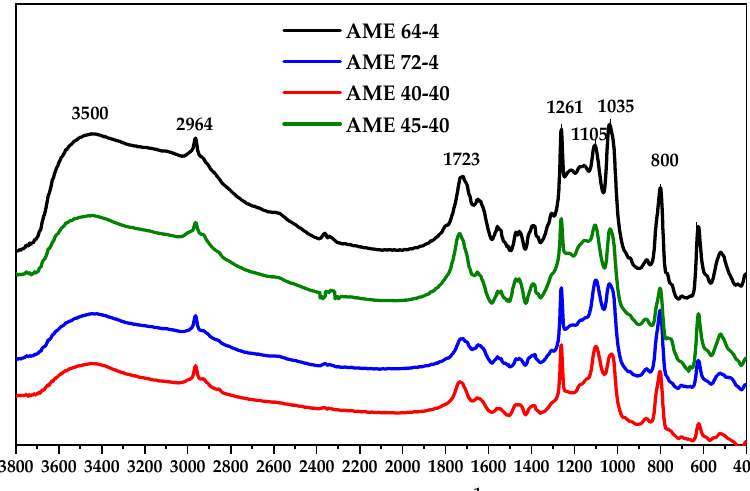
Figure 4. FTIR absorption spectra of the AME catalysts.